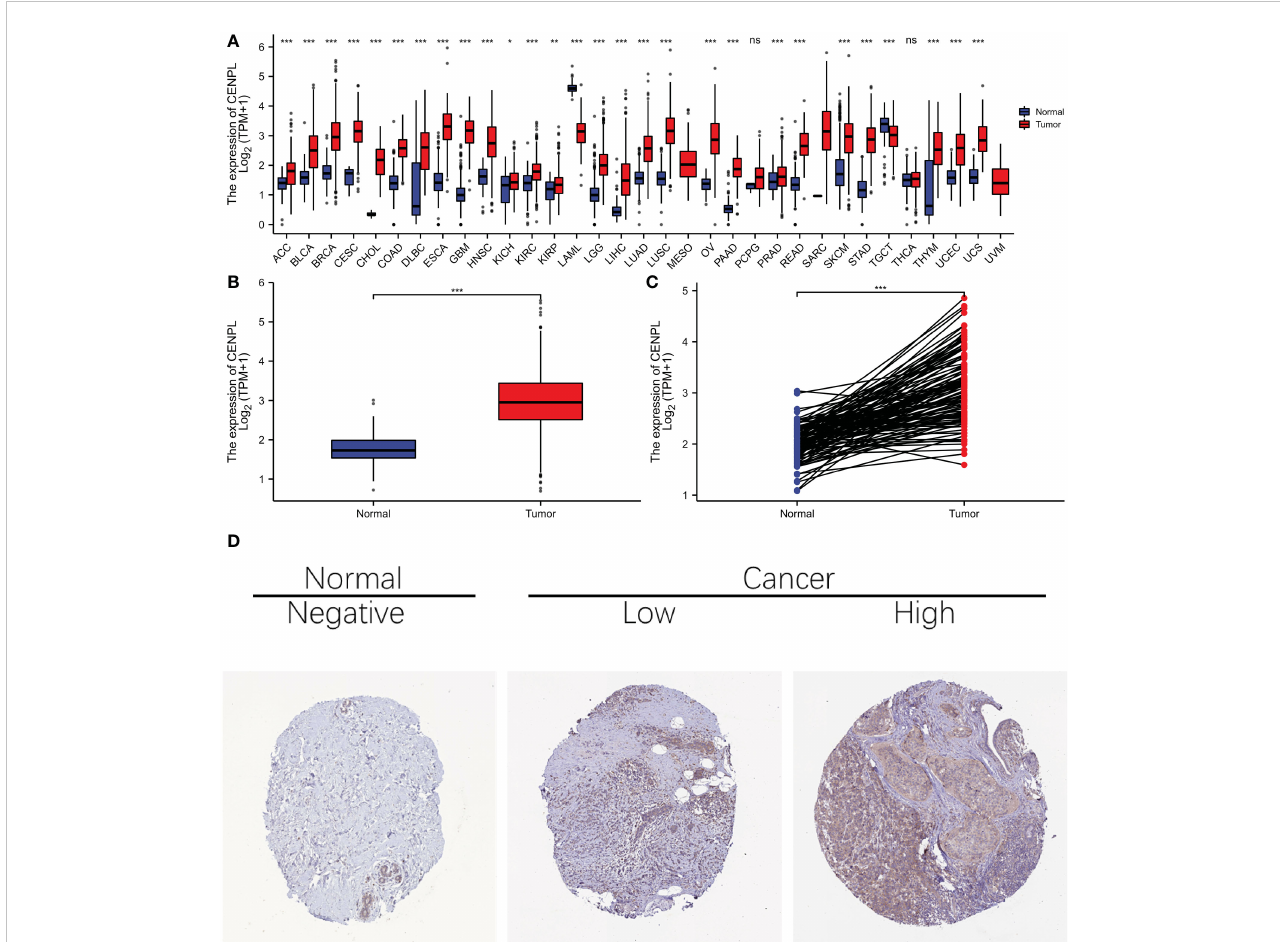
FIGURE 1 The expression difference of CENPL in cancer tissue and normal tissue. (A) Expression of CENPL in pan-cancer and adjacent normal tissues in TCGA and GTEx databases. (B) expression of CENPL in unpaired breast cancer samples in TCGA-Brca database. (C) expression of CENPL in paired breast cancer samples in TCGA-Brca database. (D) immunohistochemistry (IHC) images from the Human Protein Atlas (HPA) database Data were shown as mean ± SD. *p < 0.05, **p < 0.01, ***p <